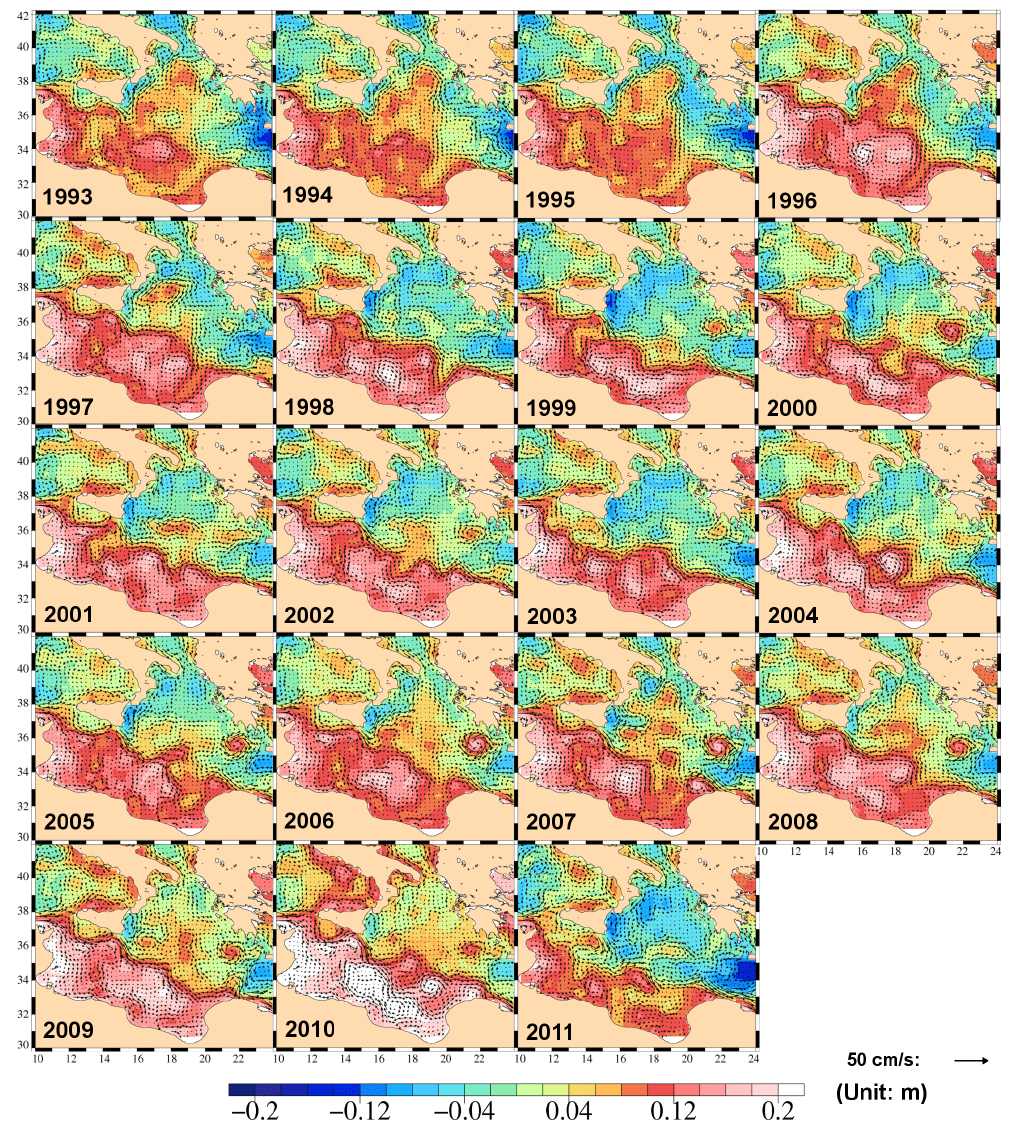
Fig. 12. Yearly averaged ADT with overlaid total velocity field in the Ionian region from year 1993 (upper left panel) to year 2011 (lower right panel). Units in m, vector field scale: 50cms − 1